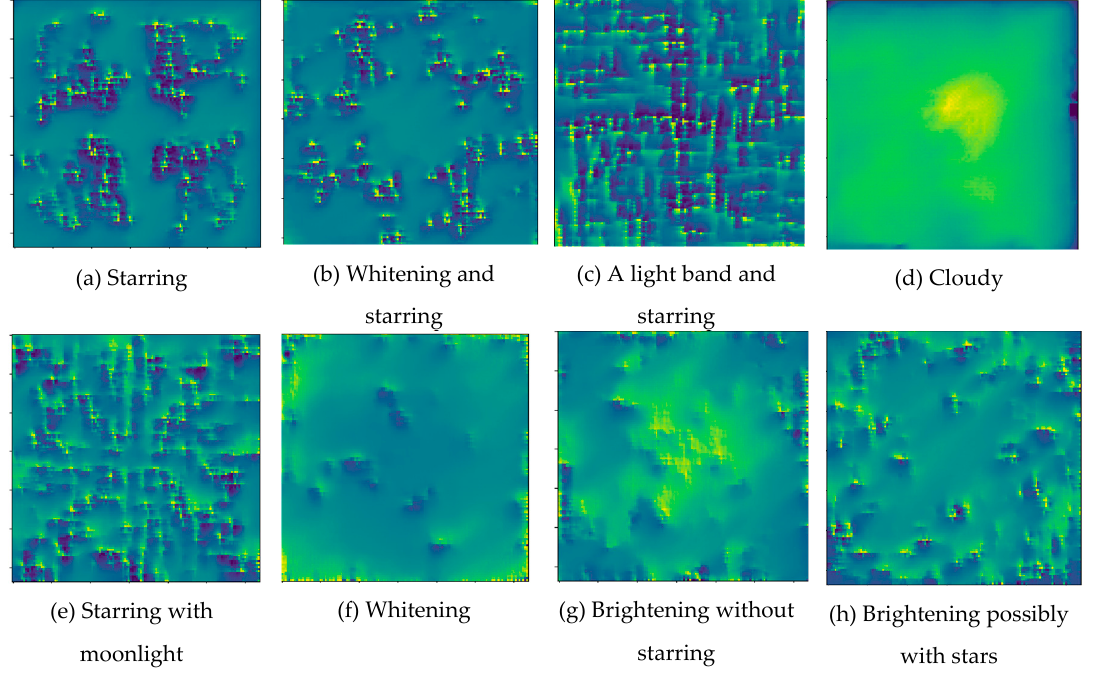
Figure 6. Maximum activation of the featured maps. Sub images ( a )–( h ) are the maximum activations of the featured maps of the corresponding raw images categories in Figure 4, respectively. All maximum activation images have 90 ◦ symmetry, which is caused by the rotation in data augmentation (in Section 4.2). The brightness indicates the weight in classification.